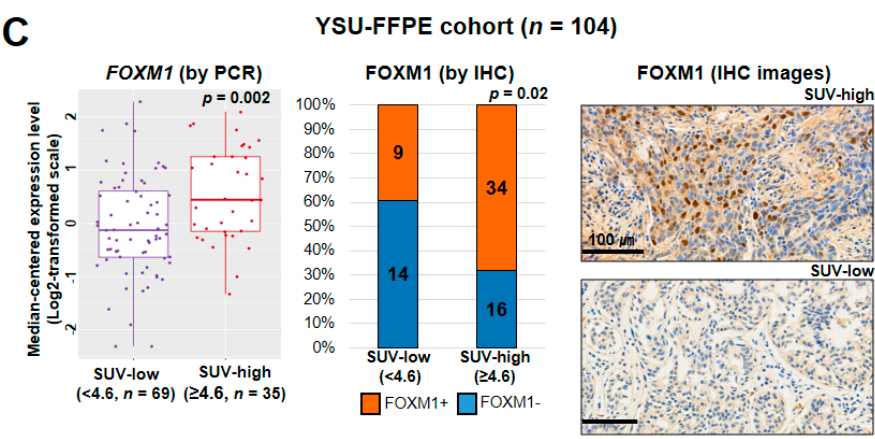
Figure 1. Comparison of the standard uptake value (SUV) and the expression patterns of SUV-correlated genes in the multiple breast cancer (BRC) patient cohorts. ( A ) Comparison of the SUV and the gene expression patterns in the YSU cohort. A total of 1424 genes were applied to generate a heat map of gene expression from 66 BRC patients whose SUV data were available. Genes were sorted by Pearson correlation coefficient between the gene expression level and the SUV. BRC samples were also sorted by the SUV. ( B ) Comparison of the SUV and the expression patterns of 229 genes in the YSU cohort. The 229 genes were commonly correlated with the SUV, both in the YSU and YSU-TNBC cohorts. ( C ) Examination of FOXM1 mRNA expression and protein levels using formalin-fixed paraffin-embedded (FFPE) tissues in the YSU-FFPE cohort ( n = 104). BRC patients were divided into two groups by an SUV cut-off of 4.6. The p -value in comparison of mRNA expression was obtained by a two-sample t -Test, whereas the p -value in comparison with protein levels was obtained by Fisher’s exact test. IHC, immunohistochemistry.